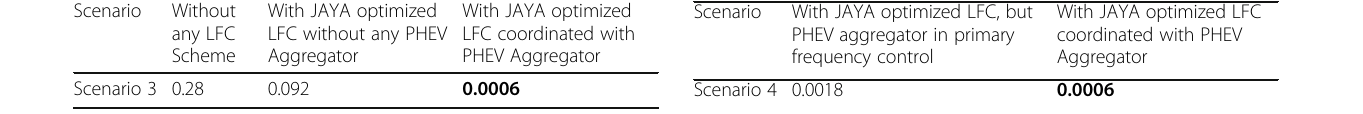
Table 5 Calculated values of fitness function (13) for scenario 4